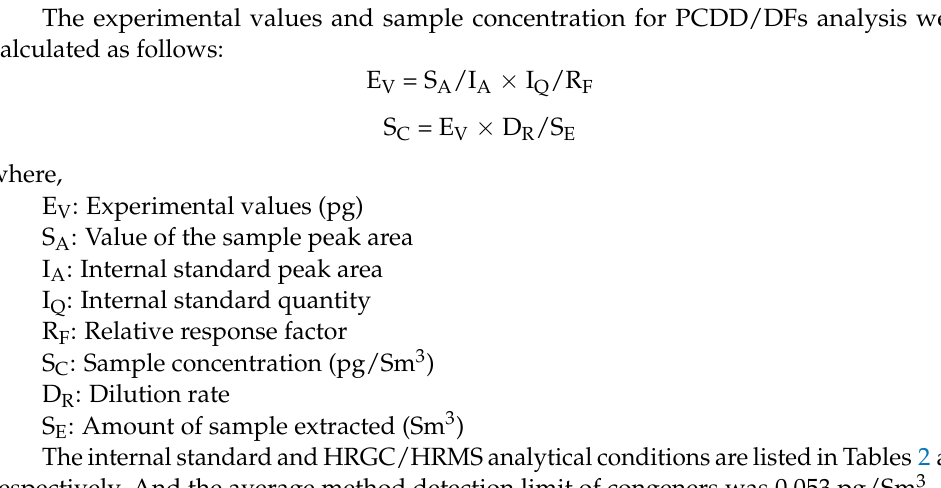
Figure 2. Experimental procedure for PCDD/DFs analysis.